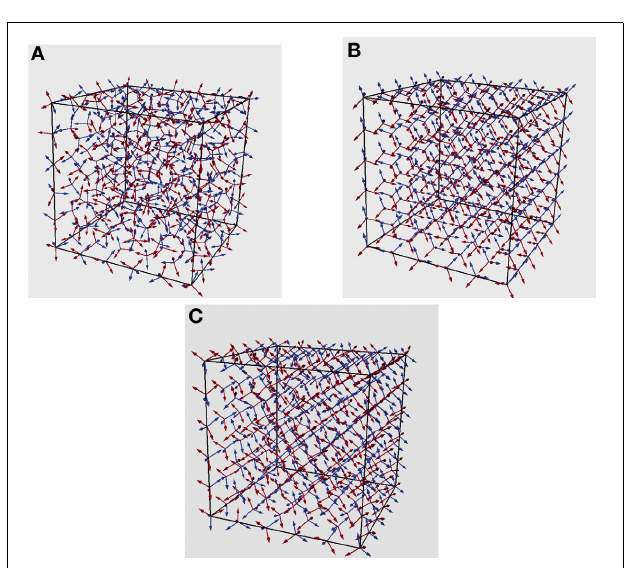
FIGURE 8 | (A) Initial random distribution of tetrahedra and the corresponding final distribution at steady state with and without thermal fluctuations in (B,C) ,